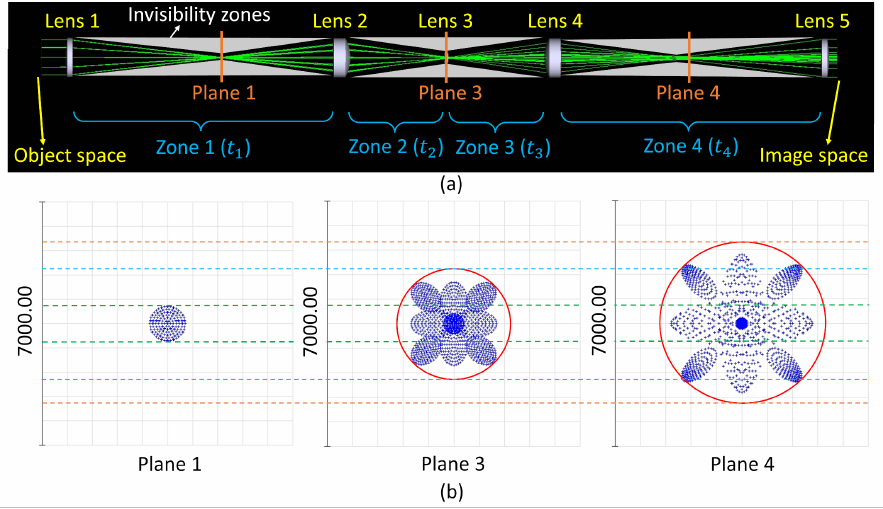
Figure 5. Case with f 3 = − 25 mm. ( a ) Ray tracing for the case f 3 = − 25 mm. We can see the zones of invisibility and the planes used to calculate the diameter of the beam at the points of maximum invisibility. ( b ) Spot Diagram for the three planes of interest using the same scale to compare the sizes.